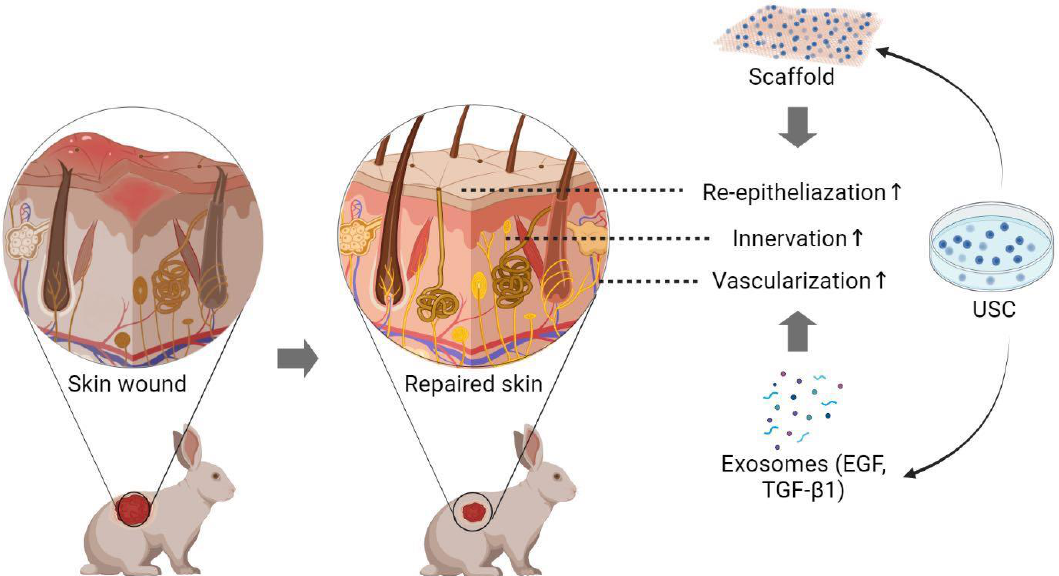
Figure 2. Applications of USC in skin regeneration and wound repair . When seeded on the scaffold and transplanted to a skin wound, USC promotes angiogenesis, re-epithelization, and innervation by generating various exosomes transporting growth factors such as VEGF and TGF- β 1. When embedded in hydrogel and injected into the brain of a rodent, USC presents the differential potential for versatile neurocytes. USC, urine-derived stem cells; VEGF, vascular endothelial growth factor; TGF- β 1, transforming growth factor β 1; ↑ indicating increase. Created with BioRender.com (accessed on 27 July 2022). Table 1. Application of various autologous stem cells in wound treatment.